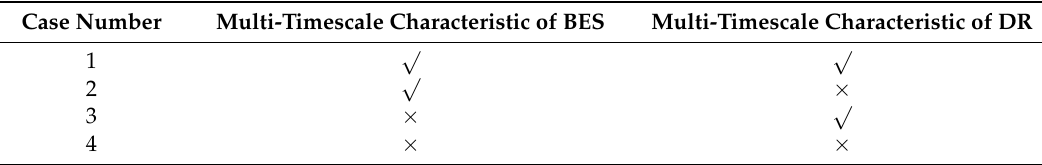
Table 2. Description of different